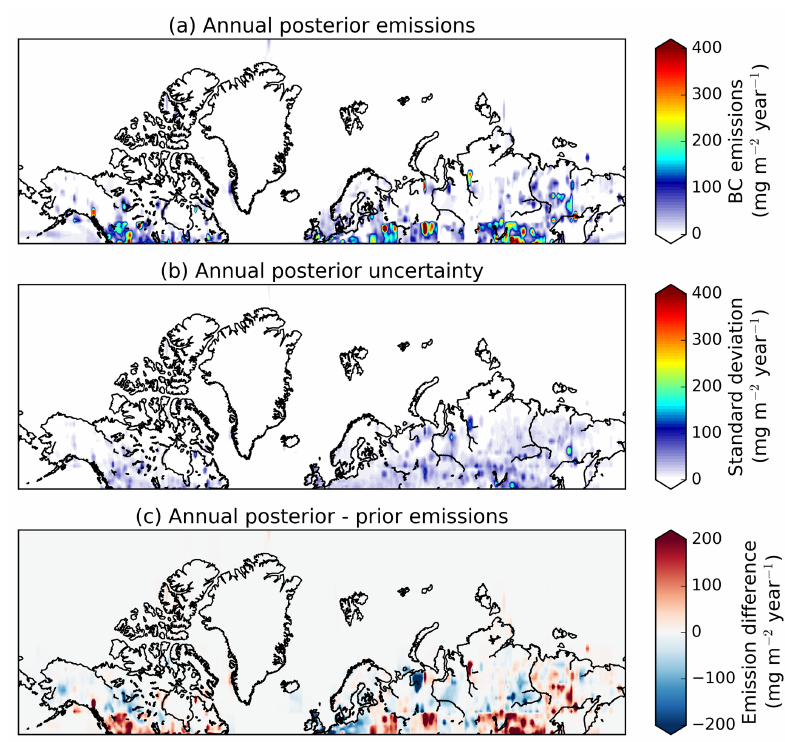
Figure 6. (a) Annual posterior emissions of BC in areas >50 ◦ N averaged for the period 2013–2015. (b) Average posterior uncertainty due to scavenging and use of different prior emissions for the same period. (c) Difference between posterior and prior emissions for